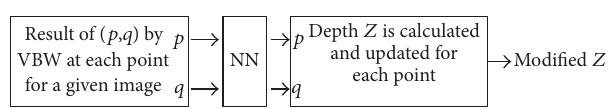
Figure 4: Flow of NN generalization.